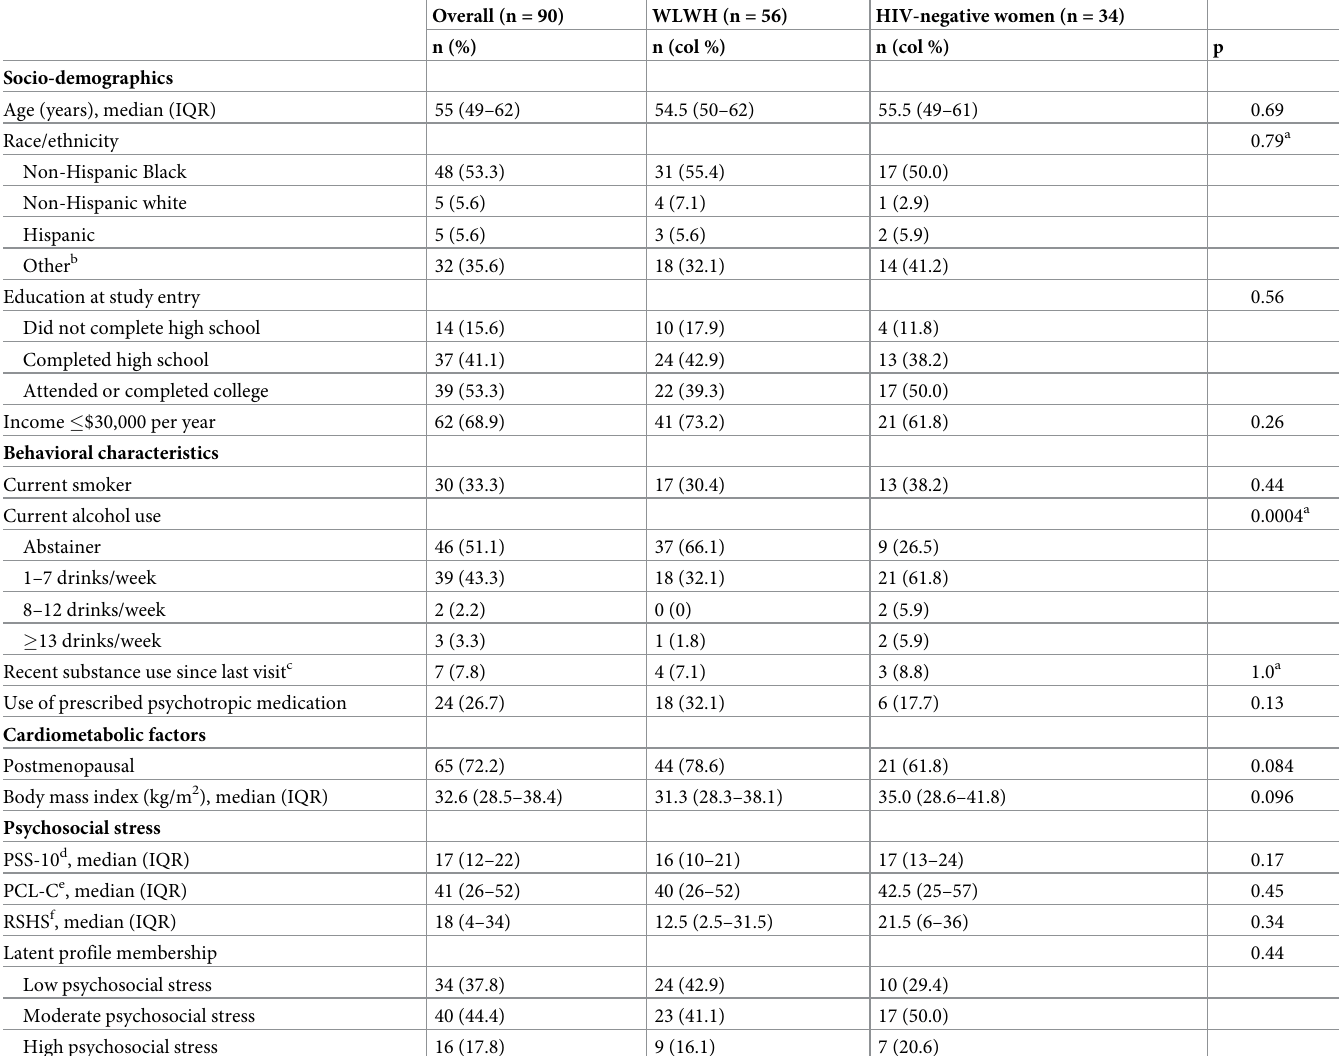
Table 3. Characteristics by HIV serostatus among women in the Women’s Interagency HIV Study, Washington, DC, 2019–2020 (n =